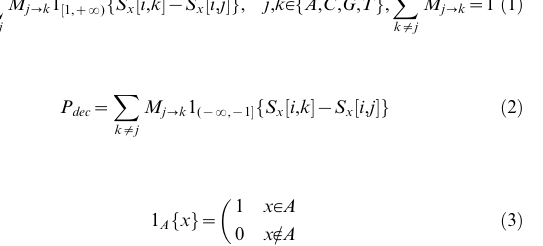
one mel footprint site for the TF). Numbers in the white bar indicate the number of shared predicted sites. (B), (D) and (F) are similar to (A),(C),(E) except that they include 200 bp flanking sequences on each side of an enhancer. Figure S2 Binding affinity change predicted by hb PWM compared to in-vitro direct measurement by MITOMI. MITOMI experiments were performed as described in the methods. Each mutation was measured in two oligonucleotides carrying the original and mutant nucleotide respectively. The two dashed lines indicate the cutoff we applied in the study. Figure S3 PWM based on mel footprints and SELEX PWM produce consistent results. Each point represents one substitution and its x, y values are the estimates of its effect on binding affinity using the footprint PWM or the SELEX PWM, respectively. 33/ 34 strong-effect substitutions are consistently assigned by the two sets of PWM into either affinity-increasing or affinity-decreasing categories. Figure S4 Impact of ascertainment on the detectability of a mutation in mel . Each box represents a TFBS, where orange indicates relatively strong binding affinity while greens indicates weak affinity. Each column is an alignment of a sample of six mel alleles with the inferred ancestral allele. In the first column, a fixed affinity- decreasing mutation in mel with a relatively large effect makes the TFBS not detectable as a footprint. In column 2 and 3, the affinity- decreasing mutations are not fixed but segregating, therefore the probability of not detecting the TFBS is proportional to the derived allele frequency (assuming a random mel allele is used in the footprint assay). Column 3–6 illustrate the situation for affinity-increasing mutations, where the substitutions are always detectable but the segregating mutations are detected with higher probability when the derived allele frequency is low. The last two columns represent cases where both alleles are detectable. To incorporate the uncertainty in the detectability of the low-affinity allele, we define a parameter f for the probability that the weak allele is not detectable. Figure S5 Site frequency spectra for different classes compared to the neutral expectation (A) Non-synonymous; (B) Synonymous No-Change (C) Preferred-to-Unpreferred; (D) Unpreferred-to- Preferred; (E) Spacers in CRM. Black: neutral expectation; Gray: observed site frequency spectrum. Figure S6 Relative excess of rare variants suggests purifying selection on affinity decreasing mutations in mel . The proportion of low frequency class(es) for affinity-decreasing mutations compared to the theoretical neutral expectation, the observed synonymous sites, or the expected proportion for synonymous sites under ascertainment assuming f ~ 1 . DAF: derived allele frequency. Figure S7 PWM derived from mel footprints (PWMmel) or their aligned sequences in sim (PWMsim) produce consistent results under our classification method. On the scatter plot each point represents a single nucleotide mutation with its x, y values being the estimates of its effect on binding affinity using either the mel PWM or the sim PWM, respectively. Green and red triangles are mutations occurring on mel or sim lineages. From the figure, the PWM have very little biases with respect to scoring mutations from the species where it is derived or the other